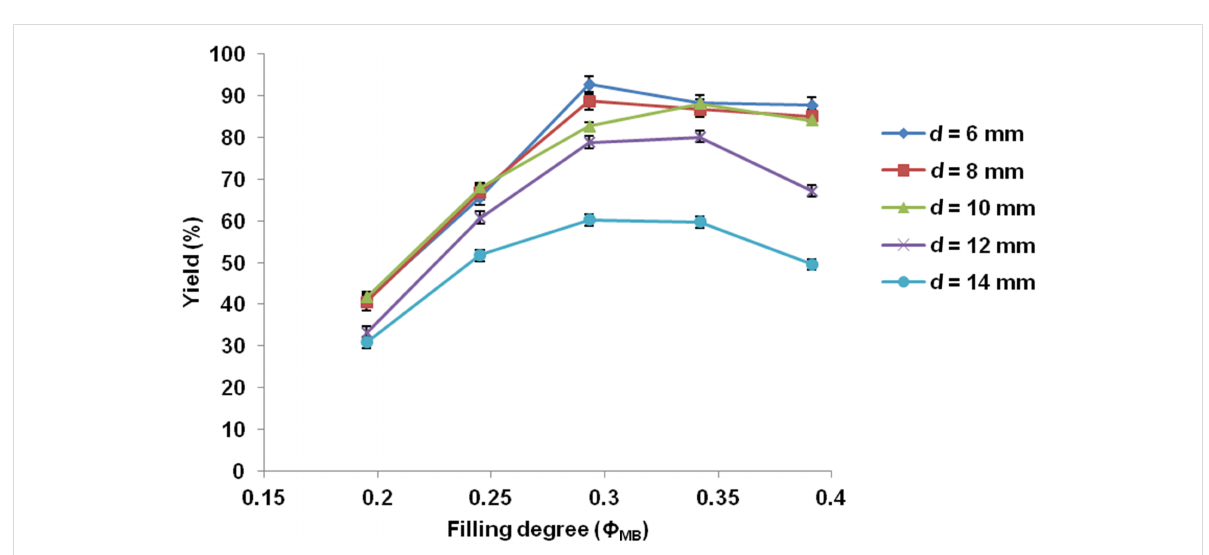
Figure 3: Influence of the milling ball filling degree with different size on the Heck reaction: 1a (1.5 mmol), 2a (2.25 mmol), Pd(OAc) 2 (5 mol %), PPh 3 (10 mol %), TEA (1.8 mmol), TBAB (5 mol %), and NaBr (10.0 g) were placed in 80 mL stainless steel vessel milling, milling at 800 rpm for 90